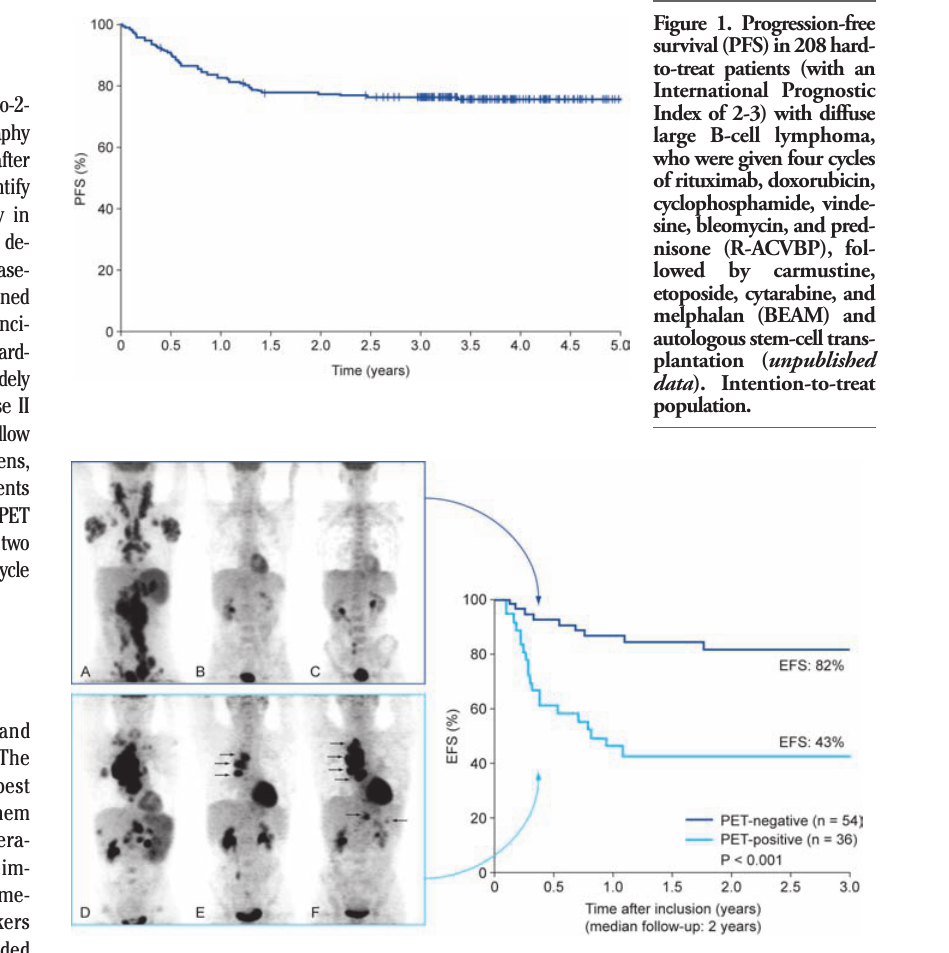
Figure 2. Examples of sequential [18F]fluoro-2-deoxy-D-glucose positron emission tomogra- phy (PET) findings in two patients. 21 Panels A-C show scans from a patient with truly nega- tive early PET , predicting complete response. Panels D-F show scans from a patient with truly positive early PET , predicting relapse. Arrows show hilar foci after two (panel E) and four (panel F) cycles of chemotherapy. The Kaplan-Meier plot shows 2-year estimates of event-free survival (EFS) according to early PET status after two cycles of chemotherapy. 21 From Haioun C et al. [18F]fluoro-2-deoxy-D-glucose positron emission tomography (FDG-PET) in aggres- sive lymphoma: an early prognostic tool for predicting patient outcome. Blood